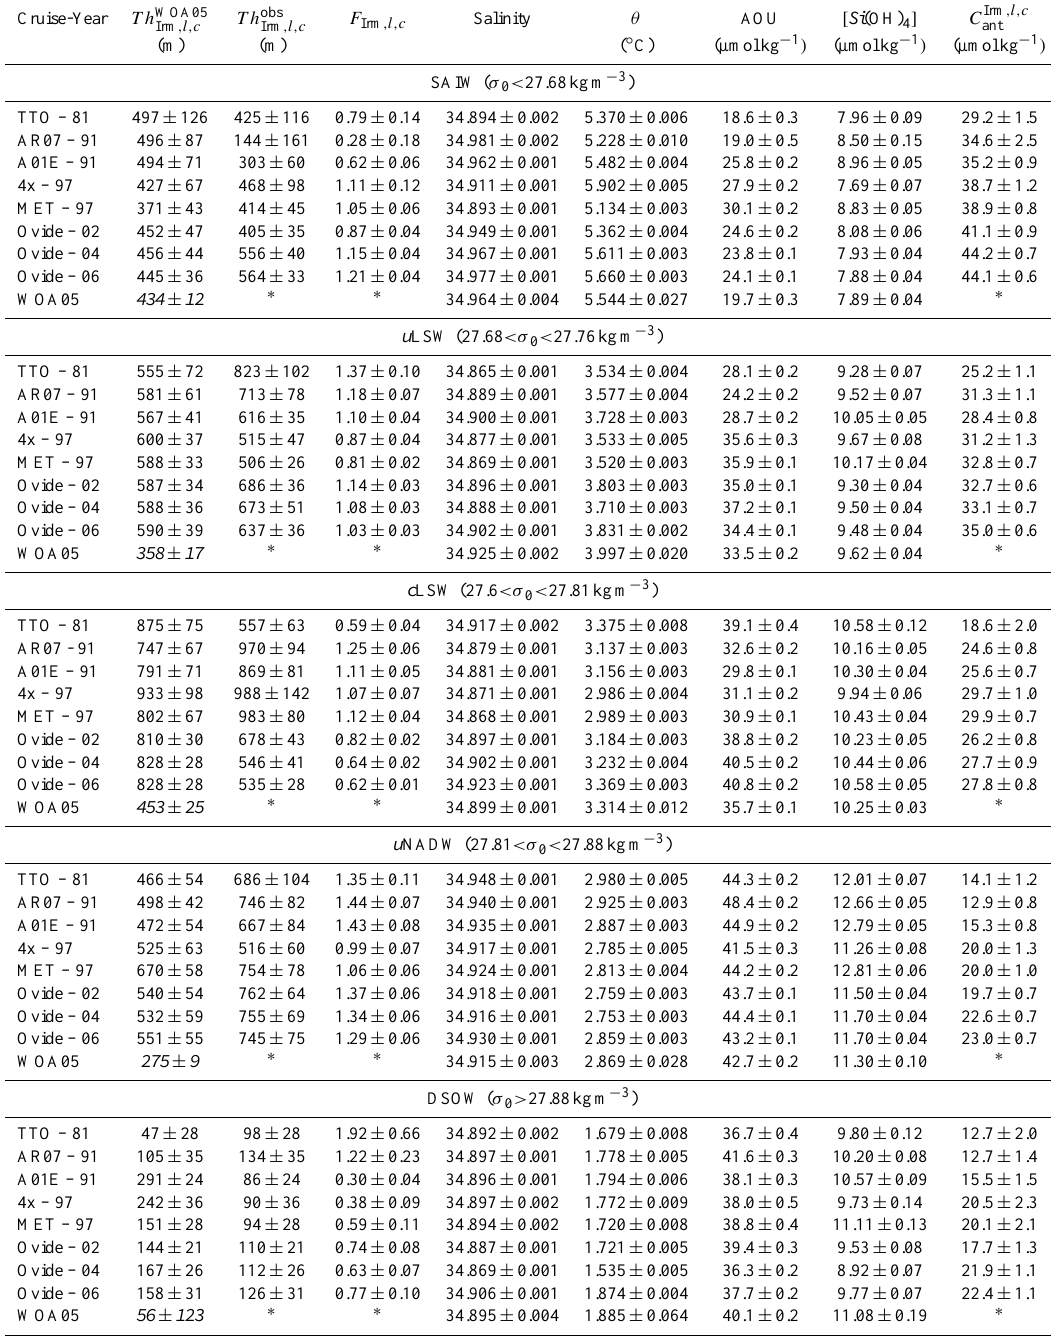
. √ N , where N = number of data) Table 2a. Temporal evolution between 1981 and 2006 of the average ± standard error of the estimate ( ± σ salinity ( S ), potential temperature ( θ ), apparent oxygen utilization (AOU), silicate concentration ([ Si (OH) 4 ]) and C ant concentration for the water masses considered in the Irminger basin (2a) , the Iceland basin (2b) and the ENA basin (2c) . In the case of Thickness ( Th ), the standard deviation is given instead of the standard error of the estimate. The acronyms “ l ” and “ c ” stand for “layer” and “cruise”, respectively. The “Obs.” acronym in the second “Thickness” column stands for “observed” from cruise measurements. The WOA05 climatological values are given as references. The WOA05 value in the “Cruise-Year” column represents the climatological basin conditions calculated from WOA05 data (details given in Appendix A). Whenever a year is listed more than once it is because more than one cruise was conducted in this particular basin, for example, the 1997 cruises FOUREX and MET97 in the Irminger basin (Table 2a). All values listed here were obtained by vertically and horizontally integrating each property within each